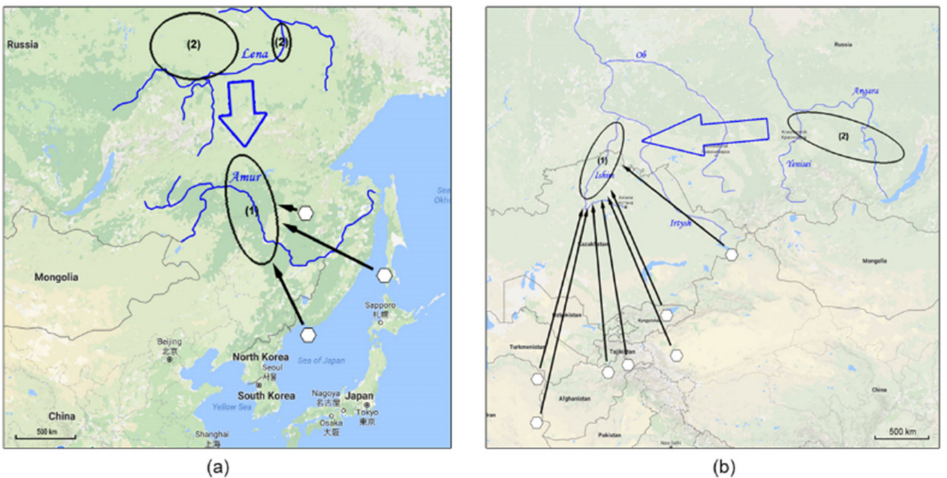
Figure 19. The river basins’ interconnection. ( a )—the Amur and the Lena Rivers, ( b )—the Ob and the Yenisei Rivers. White hexagons—the earthquakes epicenters; black ovals (1)—the flooding areas; black ovals (2)—the areas of wildfires